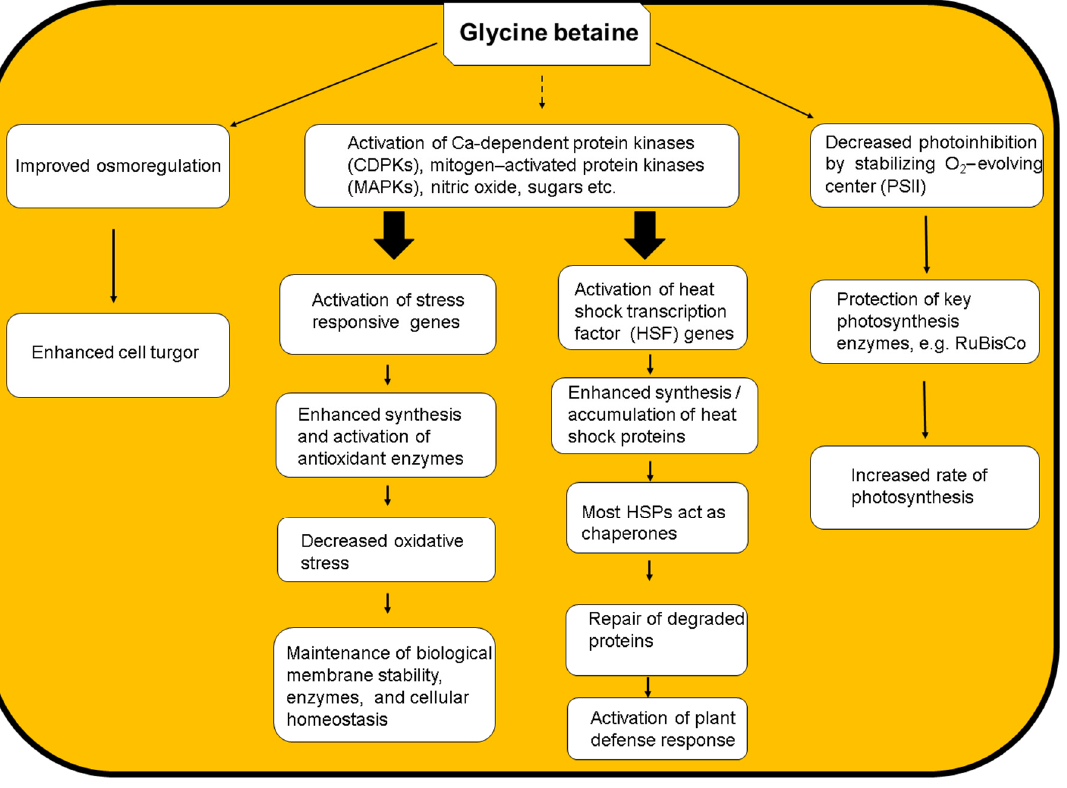
Figure 2. Proposed mechanism of glycine betaine-mediated thermotolerance in plants.